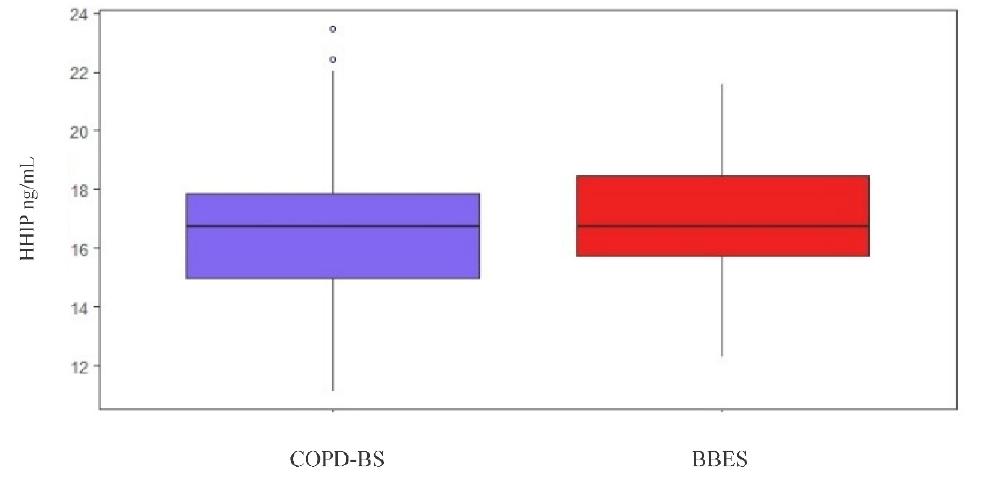
Figure 2. Comparison of protein HHIP in serum levels among COPD ‐ BS vs. BBES.